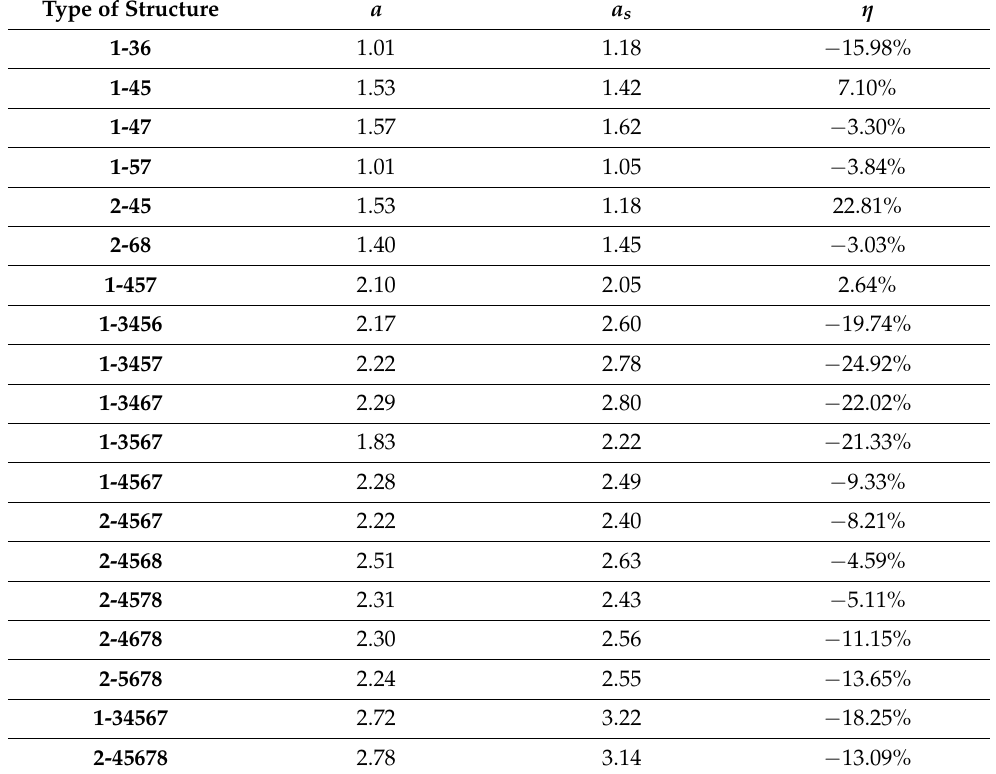
Table 3. Obtained values of the slope, a , and calculated values (assuming the perfect additivity) of a s and η (relative error of additivity) for poly(CF 3 )substituted naphthalene derivatives in dependence of its’ SESE values on SESE values of X-( p -Ph)-CF 3